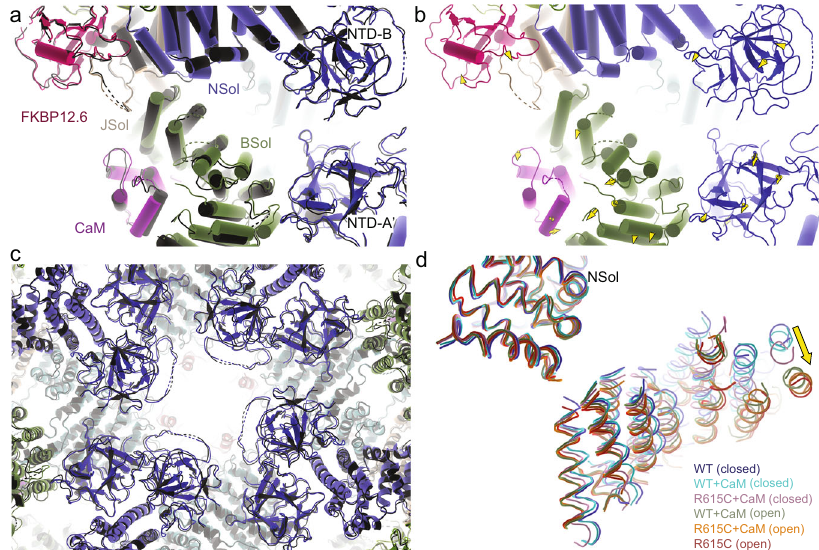
Fig. 9 In the presence of apoCaM, the R615C mutation results in only subtle changes when comparing the open states of WT and mutant pRyR1. a Superposition, based on the Nsol, of open WT pRyR1 + apoCaM (colors) and open R615C pRyR1 + apoCaM (black). In this state, the differences between WT and R615C are subtle. b Same view as in panel ( a ), but showing only the closed WT pRyR1 + apoCaM, with arrows indicating the extent of shifts >2 Å going from open WT pRyR1 + apoCaM to open R615C pRyR1 + apoCaM. The extent of the shifts is much smaller in relation to the closed structures (Fig. 8b). c Overall superposition of open WT pRyR1 + apoCaM (colors) and open R615C pRyR1 + apoCaM (black), with a close-up around the NTDs of different subunits, highlights the similarity between WT and R615C in this state. d Superposition, based on the Nsol, of all six structures described in this study. This highlights the range in the angle of the Bsol relative to the Nsol, in the order WT (no CaM) ≈ closed WT + apoCaM < closed R615C